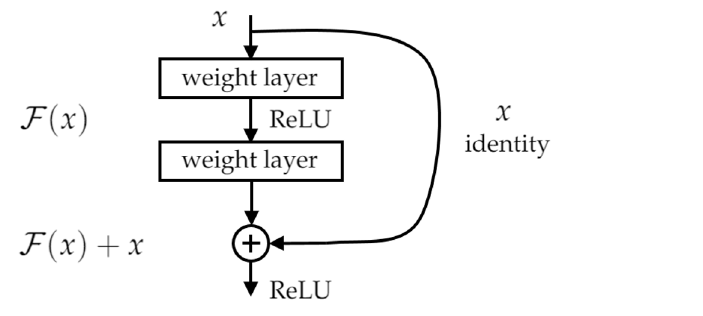
Figure 12. Residual learning